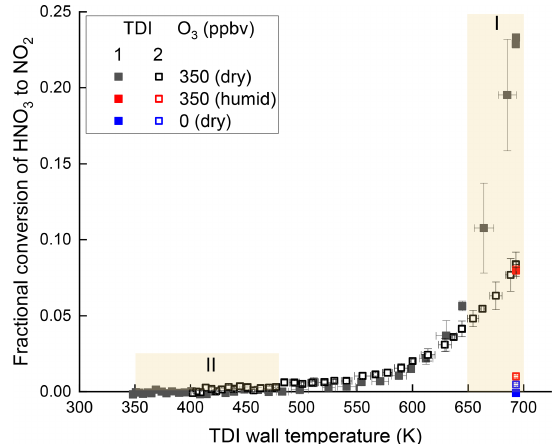
Figure 5. Thermograms of nitric acid (22ppbv) in either dry (black) or humidified air (RH = 55% at 23 ◦ C, red) obtained with TDI-1 (closed squares) and TDI-2 (open squares). The O 3 mixing ratio was either zero or 350ppbv in the non-humidified experiment and 350ppbv in the humidified experiment. The error bars denote stan- dard deviation (1 σ , 1min) of the